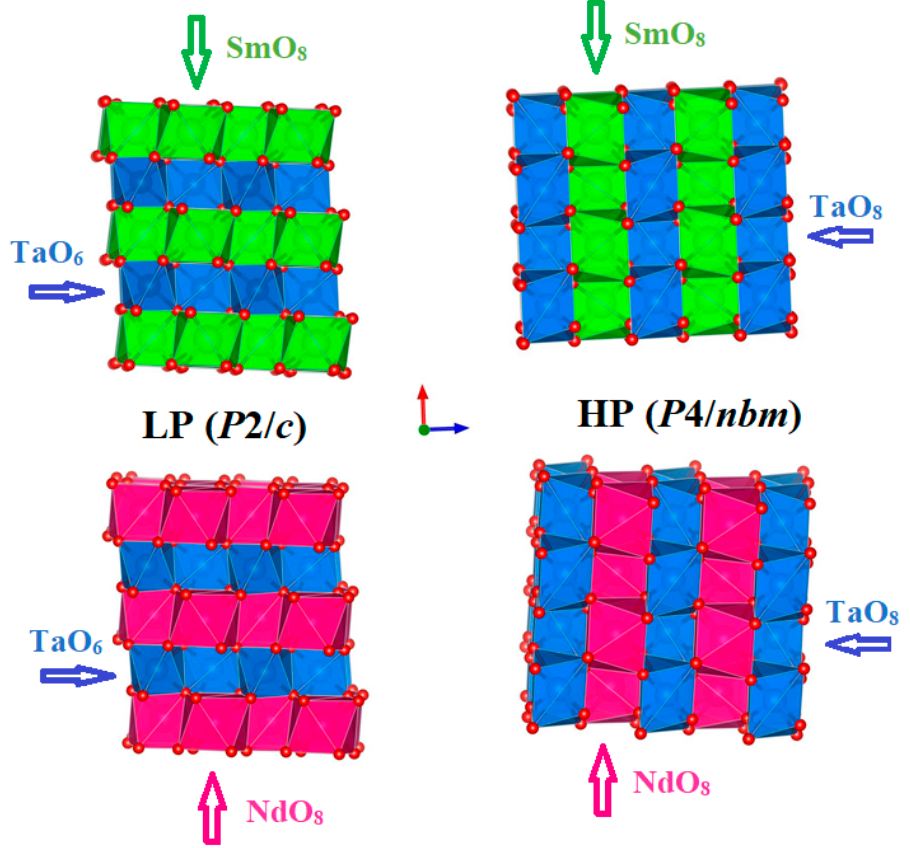
Figure 1. Polyhedral representation of SmTaO 4 (upper) and NdTaO 4 (lower) in both LP ( P 2/ c ) and HP ( P 4/ nbm ) phases. Sm, Nd, Ta, and O atoms are green, pink, blue and red, respectively. Table 1. Comparison of simulated ambient pressure lattice parameters and constituent bond lengths of NdTaO 4 and SmTaO 4 with previously reported experimental values.